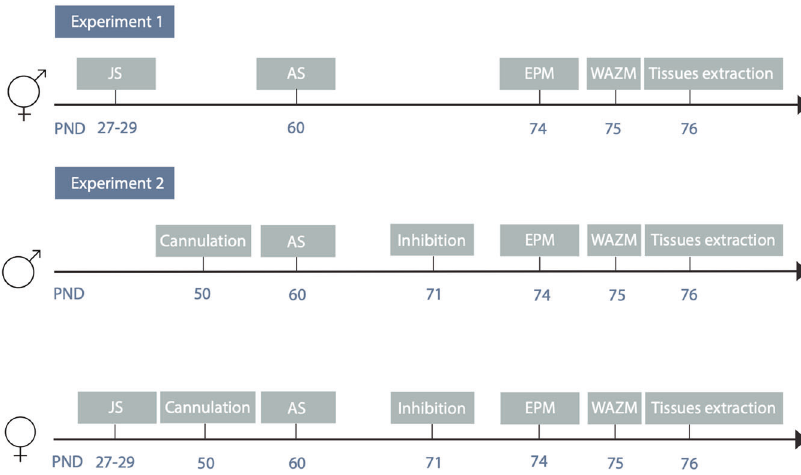
Fig. 1 Timeline of experiment 1 and experiment 2 experimental